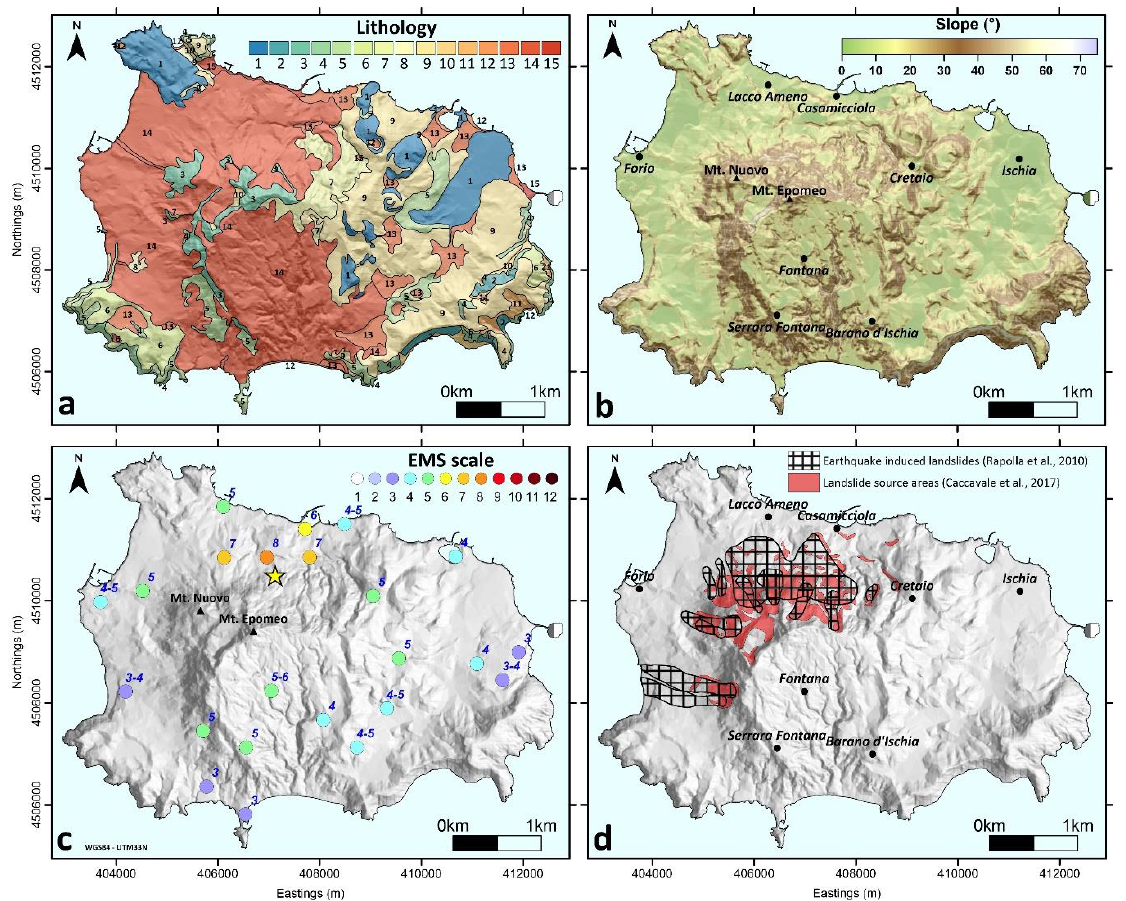
Figure 5. The available dataset for the Ischia Island. ( a ) Geolithological map, scale 1:5000 form Caccavale et al. [19]; ( b ) Slope map derived from the 10-m resolution TINITALY digital elevation model (DEM); ( c ) Macroseismic intensity estimated according to the European Macroseismic Scale (EMS) after the 21 August 2017 earthquake [1]; ( d ) Map of areas affected by past earthquake-triggered landslides [6] and the location of the landslide source areas [19]. The yellow star identifies the Ischia earthquake epicenter.